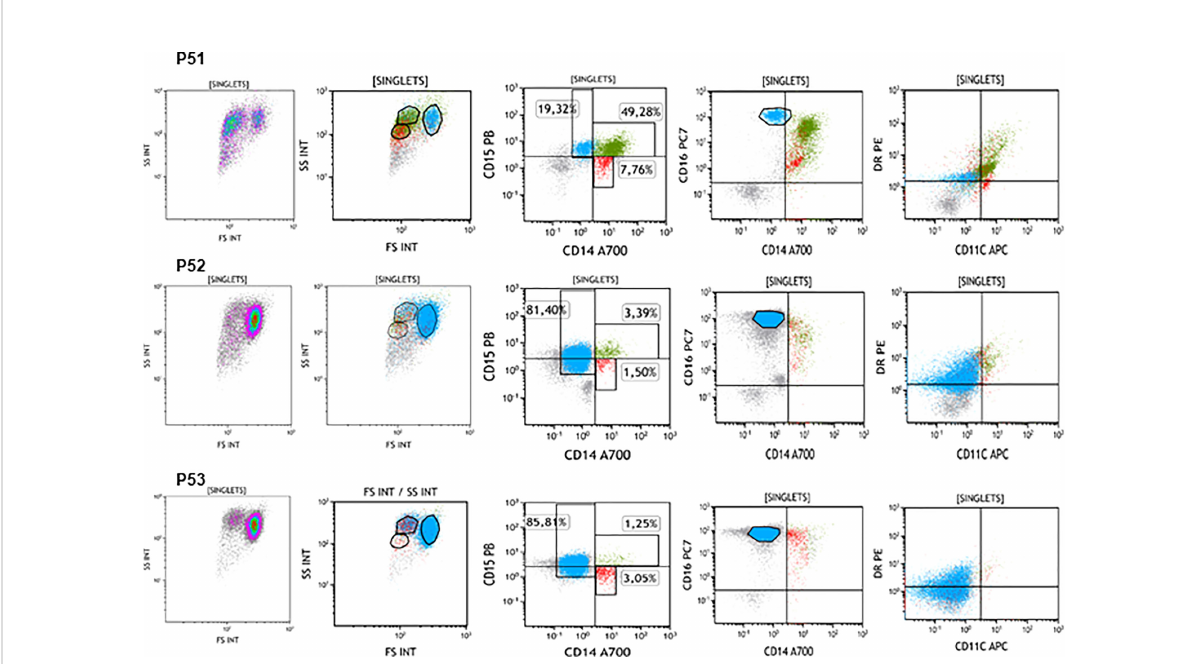
FIGURE 5 Different populations of leukocytes described by fl ow cytometry. Urine from 3 bladder cancer patients (P51-P53) treated with BCG was collected before the 6 th instillation (week 6 of treatment) and cells were analysed by fl ow cytometry in parallel. 3 populations could be identi fi ed in the FSC/SSC plots corresponding to CD15 + cells, CD14 + cells and CD14 + CD15 + cells. However, different proportions of these populations were detected in each patient. These three populations were positive for CD16 although with different intensities and had different levels of expression for HLA-DR and